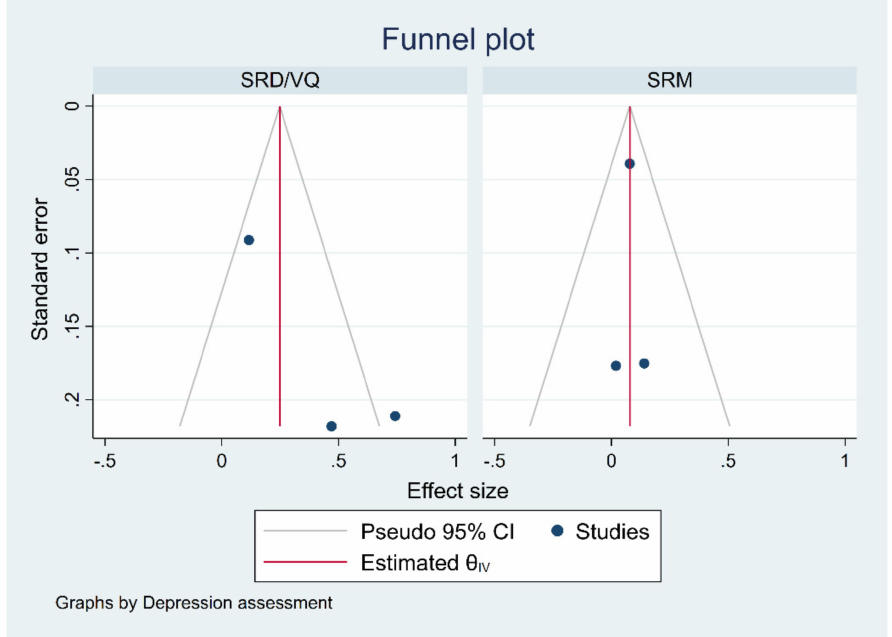
Figure A6. Funnel